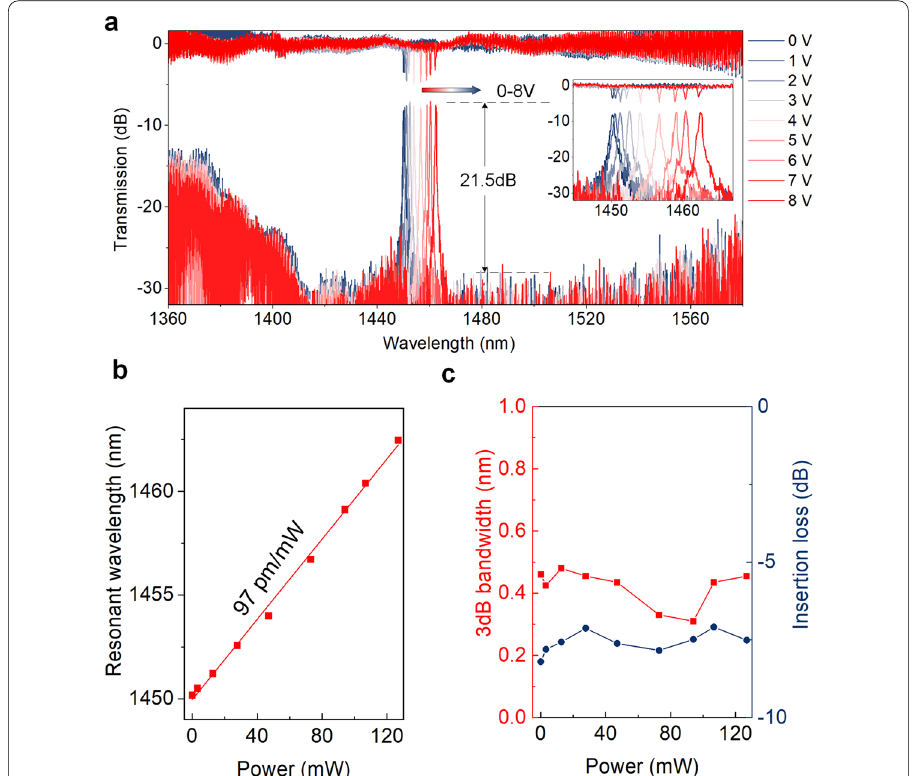
Fig. 6 Dynamic tuning characterization. a Measured transmission spectra of the fabricated devices with various bias voltages, inset: zoom-in view of the peaks. b Resonant wavelength shifts with various heating powers. c 3-dB bandwidth and insertion loss variation with different heating